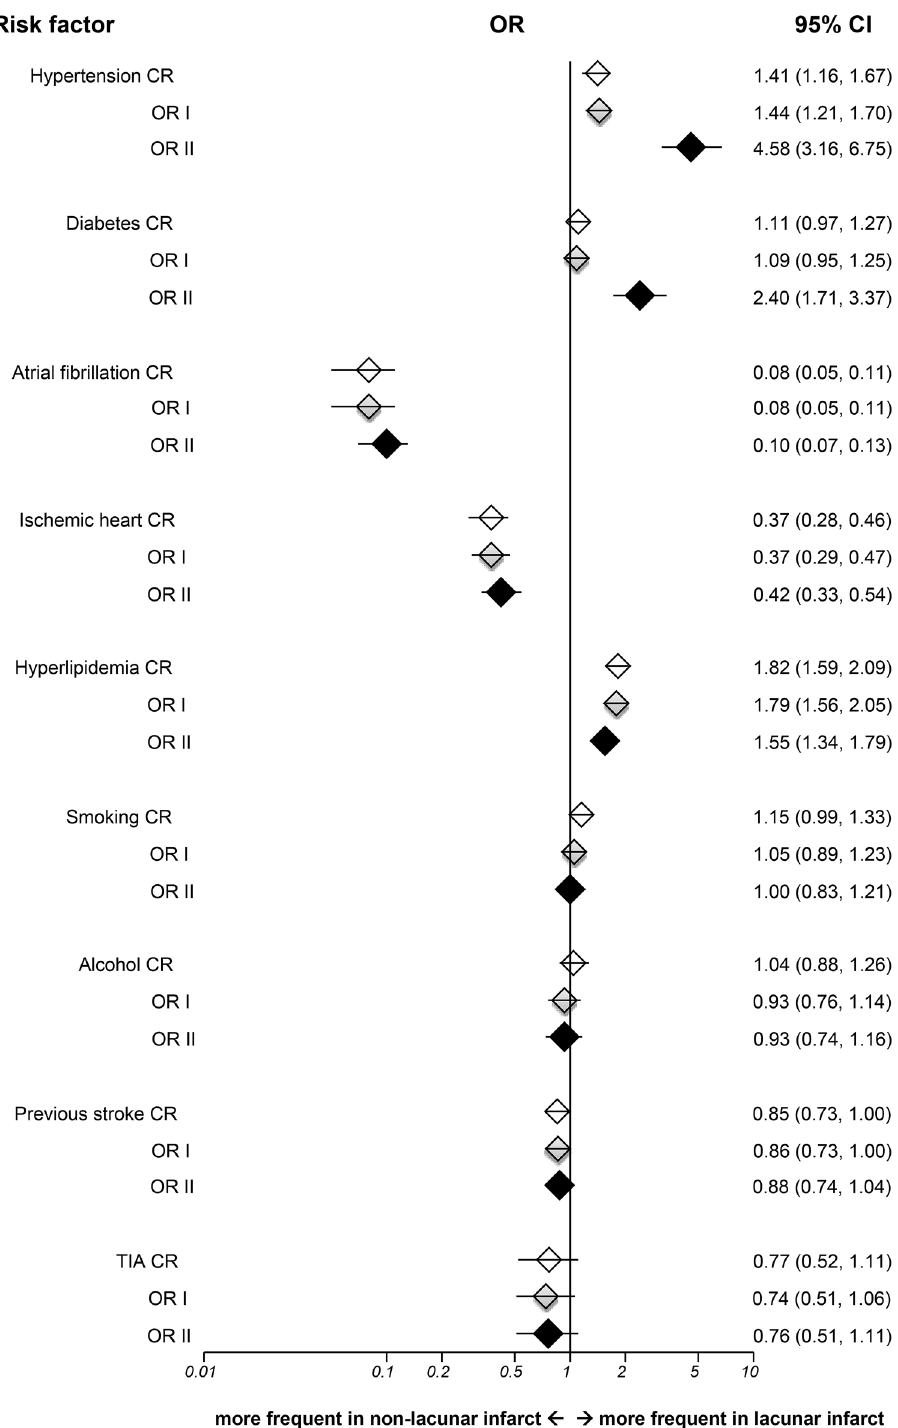
Figure 4. Risk factor analyses for lacunar versus non-lacunar infarct in OCSP classification. OR = odds ratio; CR = crude odds ratio; OR I = adjusted odds ratio I; OR II = adjusted odds ratio II; TIA = transient ischemic attack; CI = confidence interval; Horizontal lines represent 95% CIs. Diamonds represent pooled